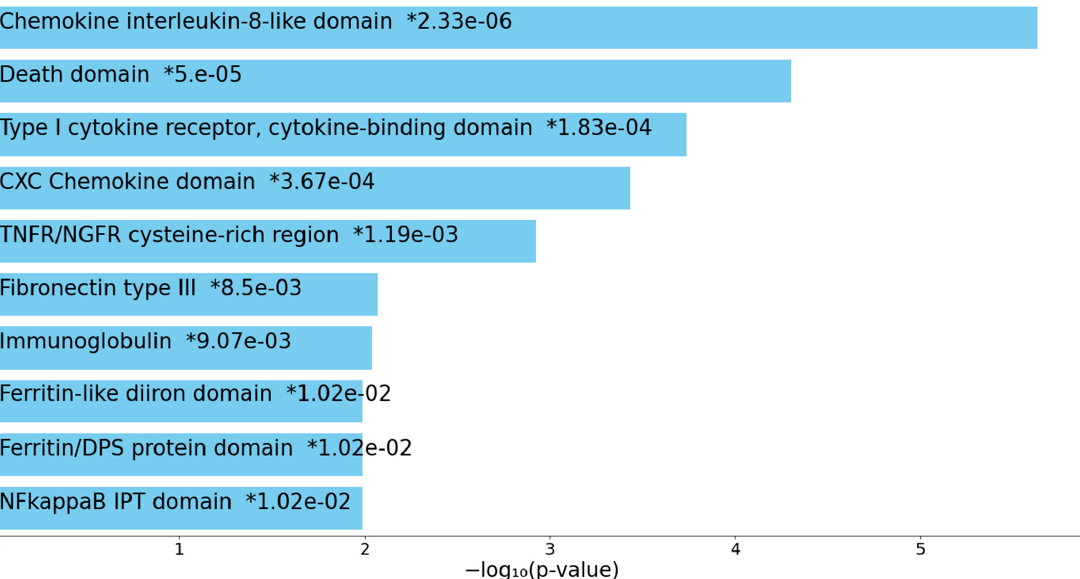
Figure 4. Heatmap of enriched InterPro domains showing the top 10 functions that were overexpressed in the first protein subnetwork of patients who died due to ischemic stroke (accumulative hypergeometric p -values). “Colored bars correspond to terms with significant p -values (<0.05); the * indicate that the term has a significant adjusted p -value (<0.05)” (Appyters, Appyter (maayanlab.cloud) as accessed 6 November 2021).